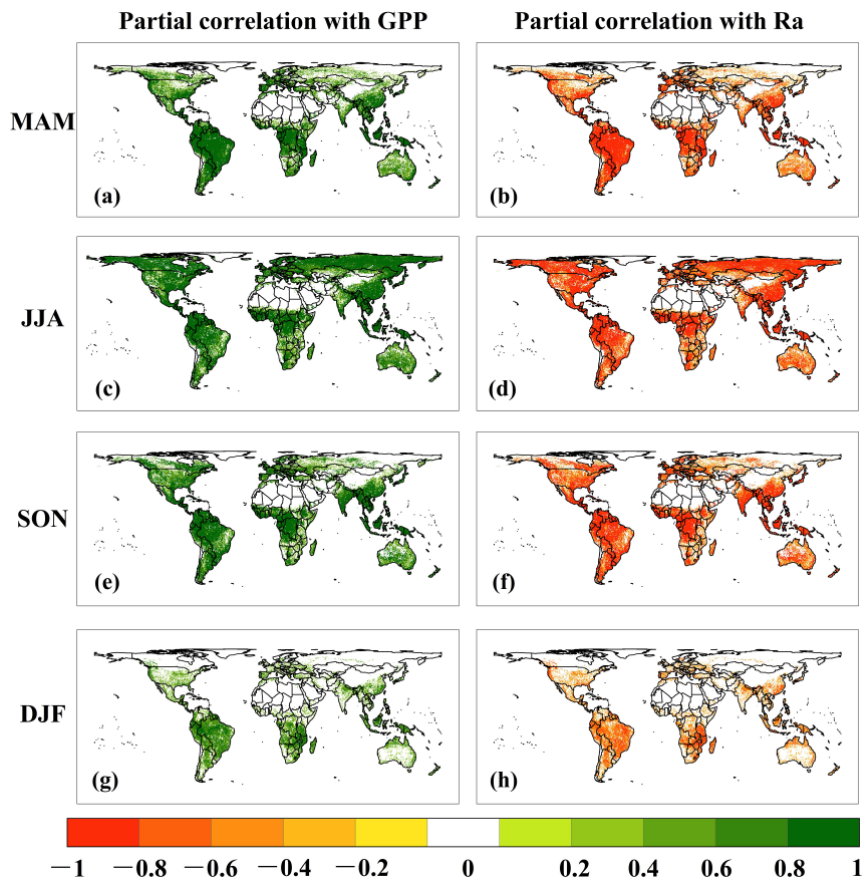
Figure 5. Spatial pattern of the partial correlation coefficients between CUE with GPP and Ra in ( a , b ) MAM, ( c , d ) JJA, ( e , f ) SON, and ( g , h ) DJF. “MAM” contains the month of March, April, and